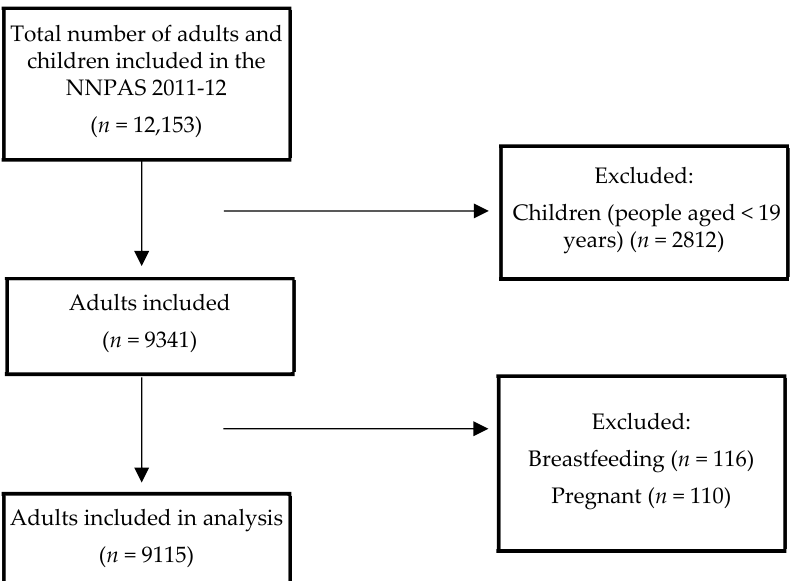
Figure 1. Flow diagram of participants included in the analysis of the National Nutrition and Physical Activity Survey 2011-12.